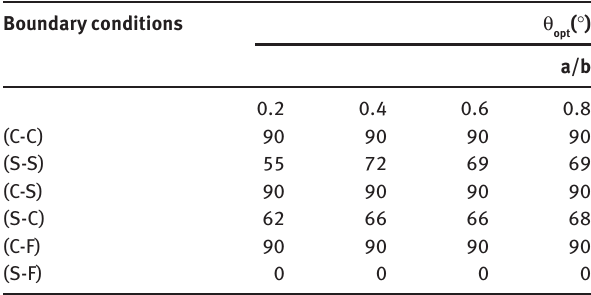
Table 3 Effect of the radius ratio on the optimum fiber orientation for the laminated annular circular plate.